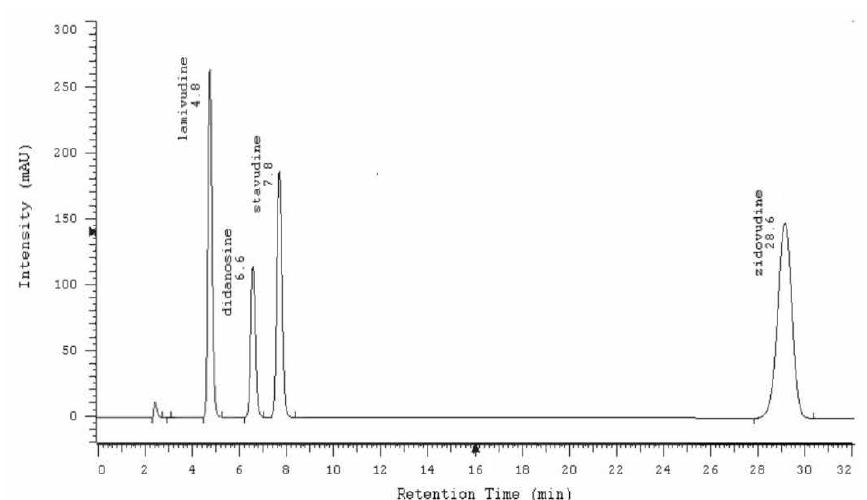
FIGURE 3 – Chromatogram of the peaks and retention times of antiretroviral drugs and ddI (IS). Determination using UV detector set at wavelength of 270 nm (see Instrumentation and chromatographic conditions section for details regarding chromatographic